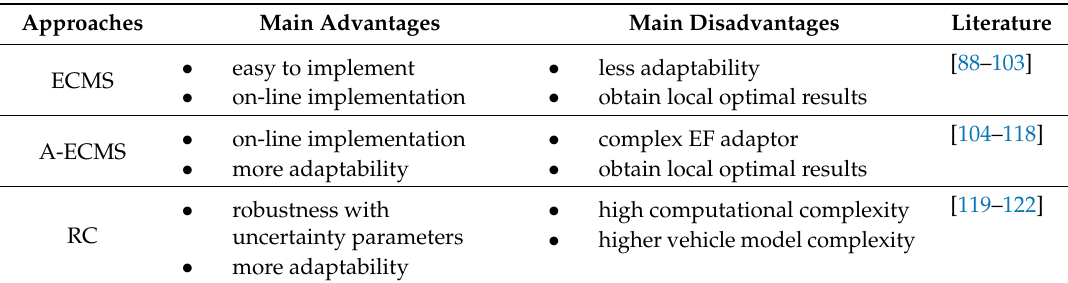
Table 2. Comparison of di ff erent